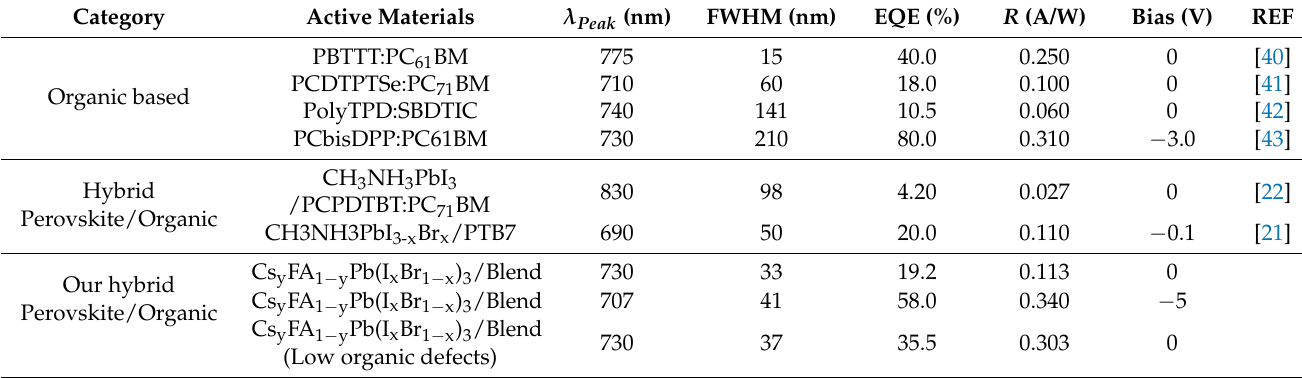
Table 3. State-of-the-art comparison showing the main metrics of some reported narrow-band NIR organic-based PDs.